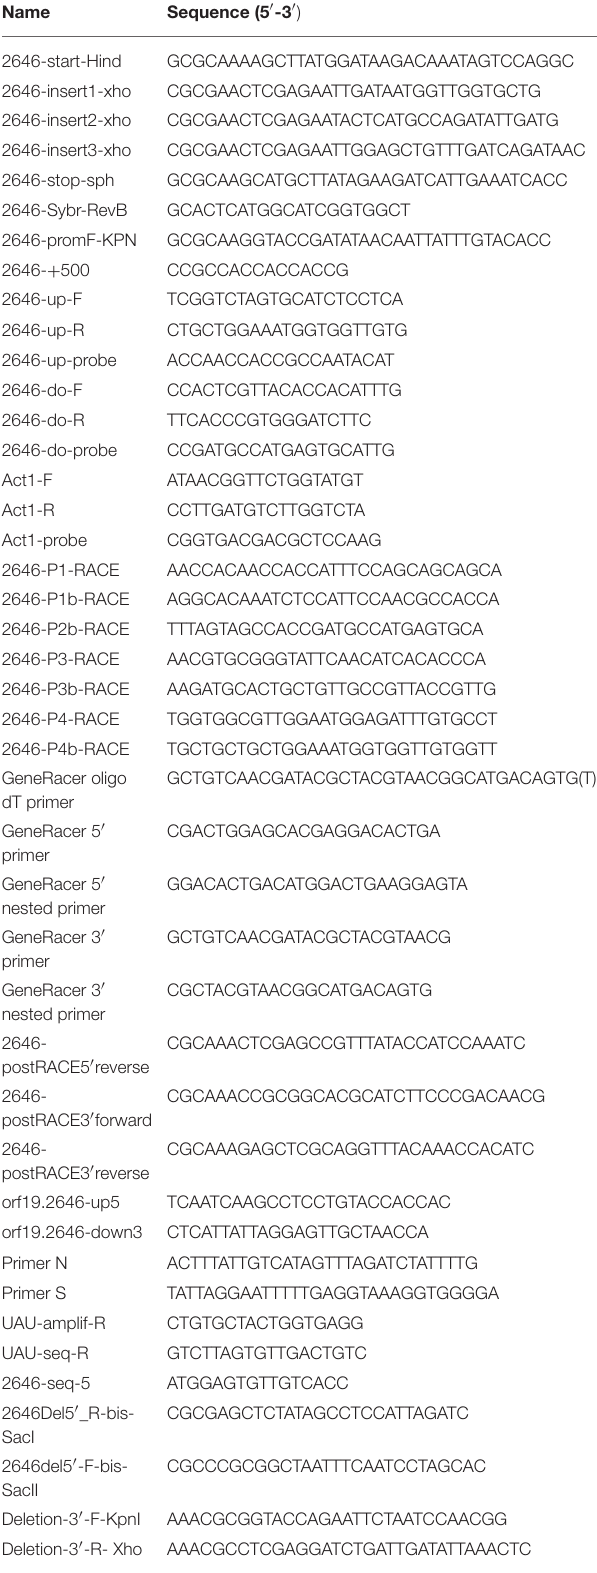
TABLE 3 | List of primers.